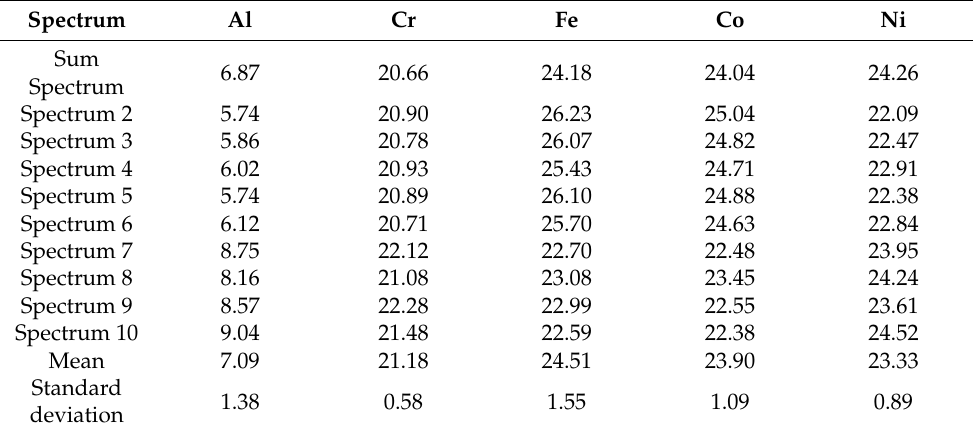
Table 3. Composition analysis results in D and ID areas and S R values for Al 0.6 CrFeCoNi and Al 0.8 CrFeCoNi alloys.